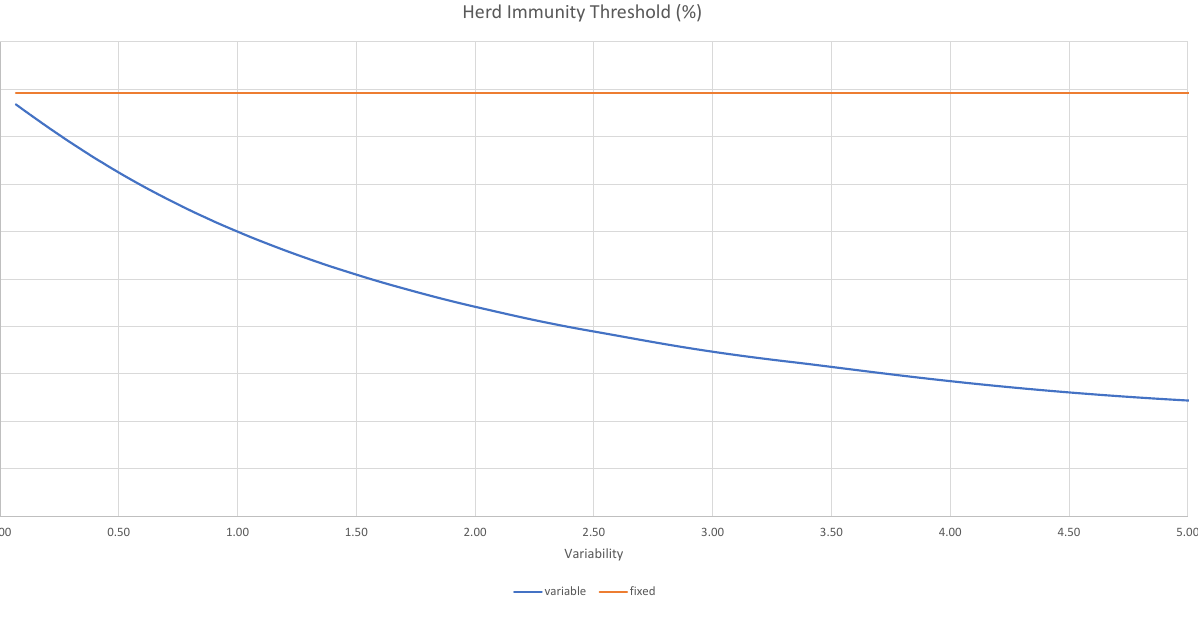
Figure 16. The herd-immunity level as a function of α for several representative values of ρ . It is clear that variability affects it in a profound